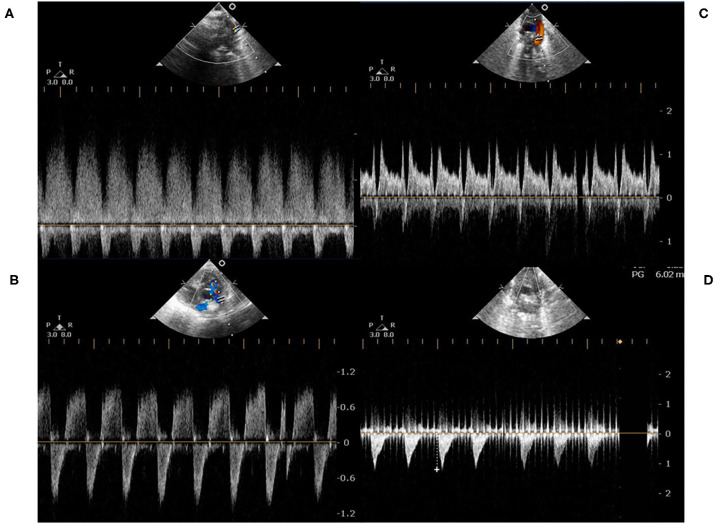
(A) represented a continuous left-to-right shunt of a PDA, which was detected by pulse-wave Doppler. At the end-diastolic phase, there was a persistent left-to-right shunt; (B,C) represented a bidirectional shunt of a PDA. At the end-diastolic phase, the shunting directions were transient right-to-left; (D) represented a right-to-left shunt. There was rare left-to-right shunt either at the systolic or diastolic phase.